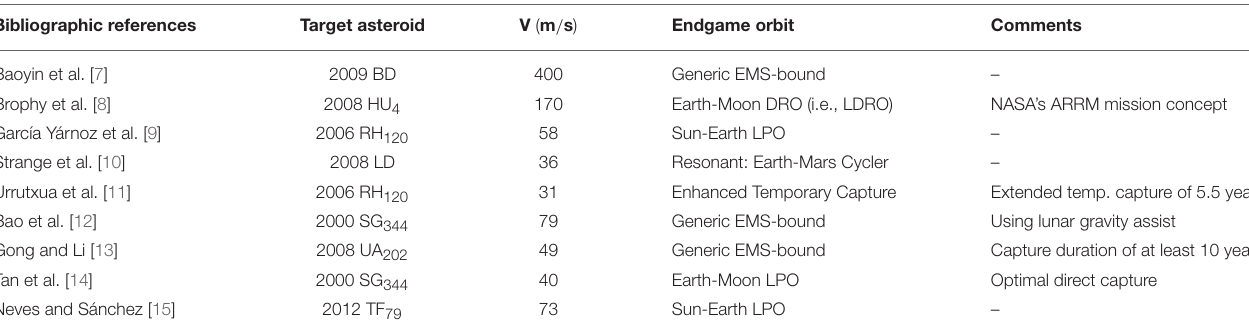
TABLE 1 | Summary of asteroid retrieval missions found in the